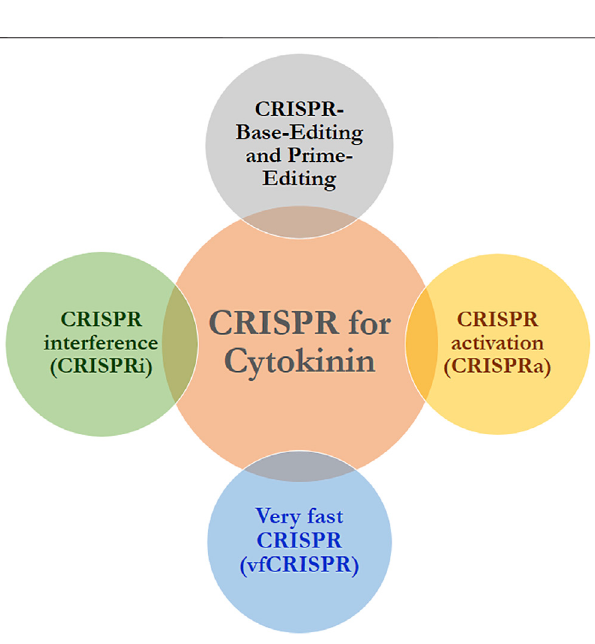
FIGURE 3 | Proposed CRISPR/Cas9 applications to target cytokinin in cropplants. CRISPRknockout(CRISPRKO)ispresentlysuccessfullyapplied (reported in the review). We propose CRISPR-Base-Editing and Prime- Editing, CRISPRi, CRISPRa and vfCRISPR can also be used in this